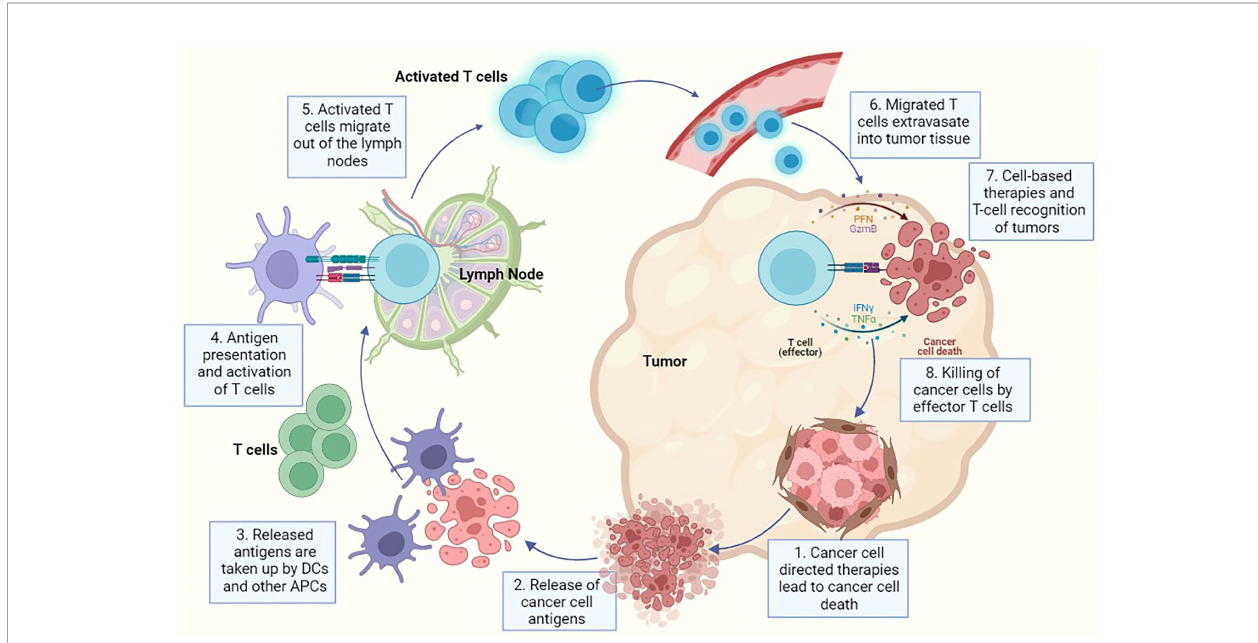
FIGURE 1 | A representative diagram for cancer progression and associated immune reaction where each step indicates a potential method of therapeutic intervention using either cancer-cell directed therapies or immune cell directed therapies. In this image - 1. Indicates killing of tumour cells using cancer-cell directed therapies like chemotherapy, radiation etc., 2. Represents the release of cancer cell speci fi c antigens after cancer cell death has been induced, 3. Represents the cancer antigen presentation to dendritic cells and antigen presenting cells, 4. Indicates priming of APCs and T cell activation, 5. Demonstrates the migration of activated T cells from the lymph node into the circulation, 6. Represents the migration of T cells into tumour tissue via extravasation through endothelial cells in blood vessels, 7. Demonstrates the recognition of cancer cells by effector T cells and also represents the point of action of multiple cell based therapies and (8) . Finally represents the killing of cancer cells after recognition by effector T cells. Multiple immunotherapies have been developed capitalizing on this particular step e.g. checkpoint inhibitors, metabolic reprogramming therapies